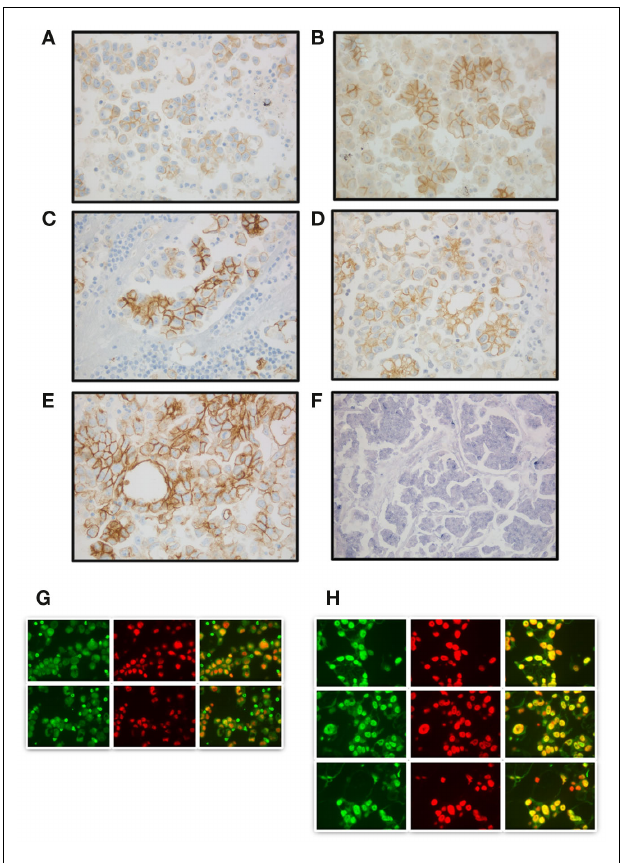
FIGURE 1 | EMT-related molecules in ovarian serous carcinoma. (A,B) Expression of E-cadherin (A) and N-cadherin (B) ; (C–E) Immunostaining for claudin-1 (C) , claudin-3 (D) , and claudin-4 (E) ; (F) in situ hybridization for Snail mRNA in a primary carcinoma. NBT–BCIP as chromogen; (G,H) Snail immunofluorescence. Snail localizes to the cytoplasm in some effusions (G) , whereas localization to the nucleus in seen in others, being more prominent after cells are cultured (H) . Green: Snail, Red: DAPI, right column: